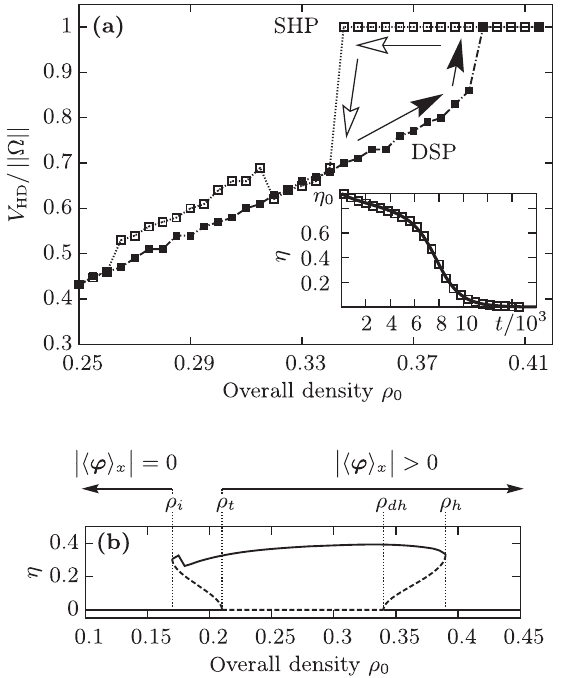
FIG. 5. (a) Hysteresis study ( σ ¼ σ 0 ¼ 0 . 25 ). Surface fraction of the HD phase against overall density ρ 0 . Solid symbols (with their paths indicated by solid arrows) indicate the system ’ s stationary state upon increasing ρ 0 quasistatically, starting at a wavelike pattern at ρ 0 ¼ 0 . 25 . Open symbols (with their paths indicated by open arrows) indicate the system ’ s stationary states upon quenching the density to successively lower values, starting from a stationary, spatially homogeneous state computed at ρ 0 . 415 . The system exhibits hysteresis, corroborating the 0 ¼ assertion that the underlying ordering transition is first order. Inset: Dynamics of the density-segregation parameter η (open data points) follows the subcritical bifurcation model [Eq. (39)] (solid line). (b) Sketch of the bifurcation diagram for the bifurcation parameter ρ 0 (at σ ¼ σ 0 ¼ 0 . 5 ). Solid lines indicate stable fixed points of the system ’ s dynamics and have been determined numerically. Dashed lines are drawn “ by hand ” and indicate the estimated position of unstable fixed